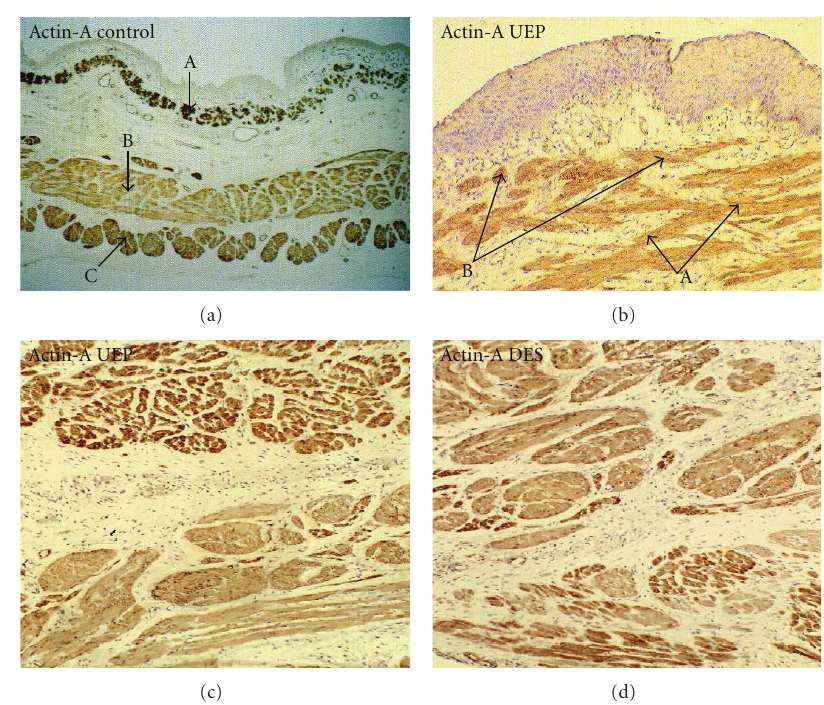
Figure 1: Actin-A. (a) Control neonatal esophagus: Anti-A immunostaining marks strongly the muscularis mucosae (A), as well as both the inner (B) and outer (C) muscle layers; (b) Presence of disarranged and fragmented muscle bundles (A) reaching the epithelial basal line and segmental agenesia of muscularis mucosae. (B) Anti-A immunostaining is reduced in the smooth musle bundles of the UEP (c), but it is weaker in (d) the